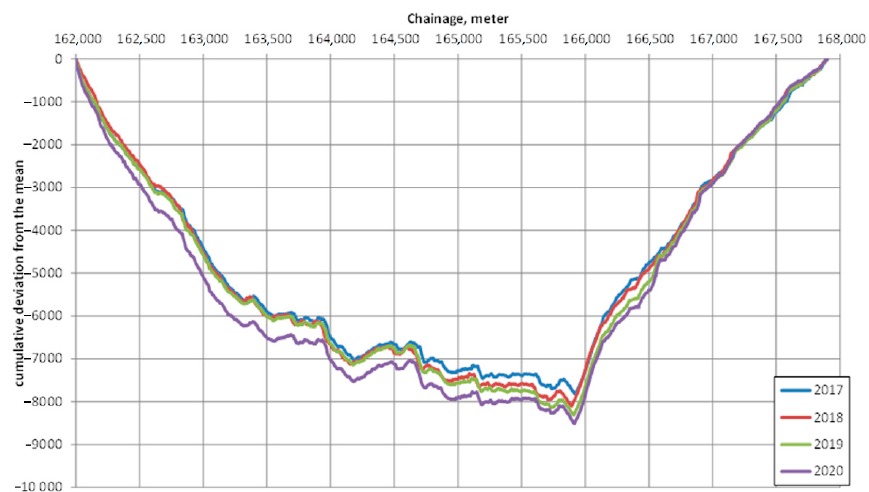
Figure 6. Cumulative deviation from the mean (section No. 4).